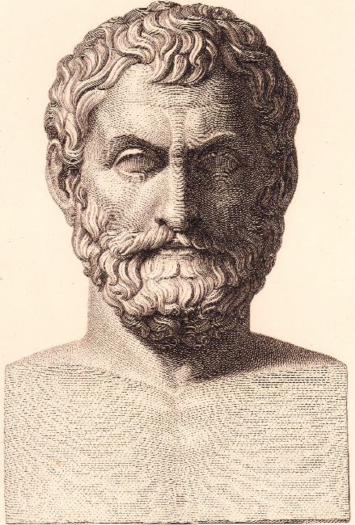
Figure 4. (Thales of Miletus; c. 624/623– c. 548/545BC), one of the Seven Sages of Greece, the first philoso- pher in the Greek tradition also recognized as the father of science (image source: Visconti,